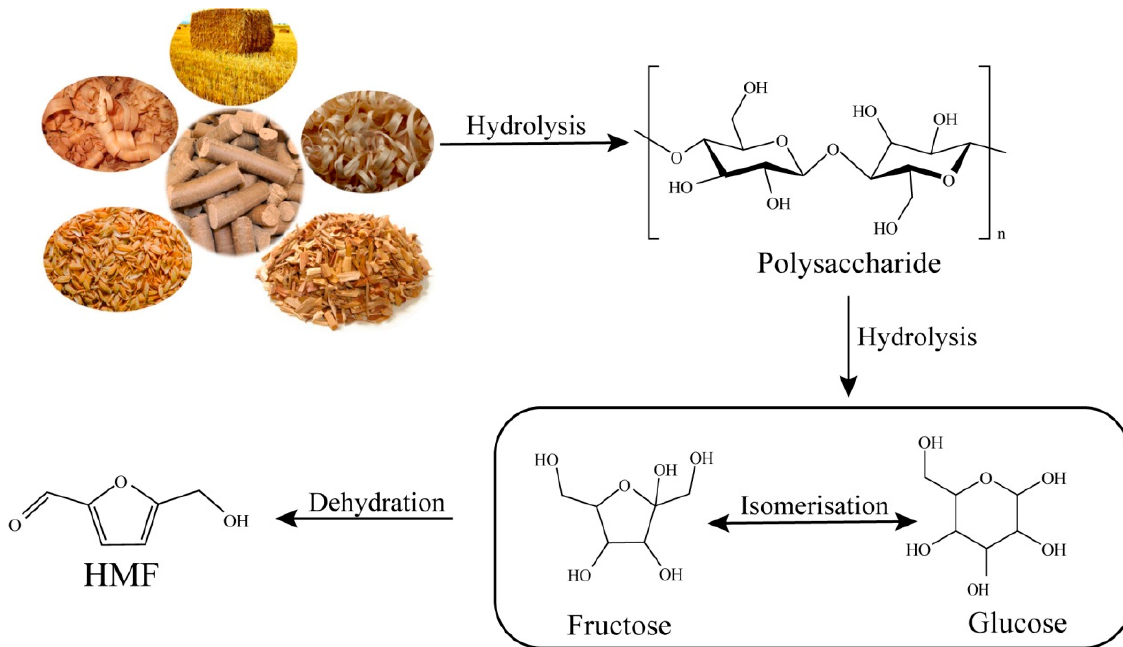
Figure 3. Catalytic conversion of cellulose into HMF.